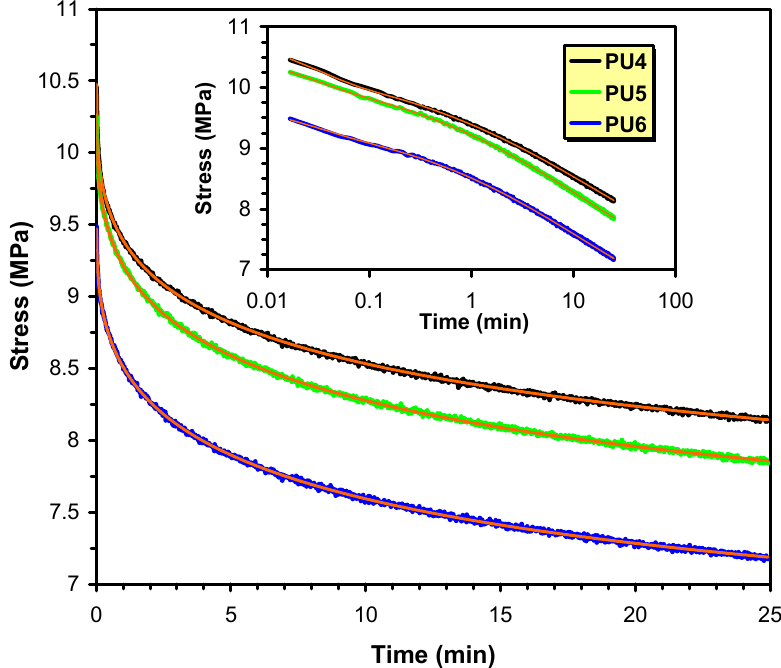
Figure 5. Stress ( σ ) versus time relaxation curves for the samples PUs 4–6 (initial elongation was 100%). The inset shows the corresponding stress ( σ ) versus time relaxation curves on a logarithmic x -axis scale. The orange solid lines represent the fitted curves by using Equation (7). The fitted parameters for PU 4 are A 1 = 0.51 MPa, A 2 = 3.61 MPa, A 3 = 7.0 MPa, τ 1 = 0.027 min, τ 2 = 17.7 min and λ = 0.33, for PU 5 are A 1 = 0.35 MPa, A 2 = 3.56 MPa, A 3 = 6.8 MPa, τ 1 = 0.027 min, τ 2 = 13.5 min and λ = 0.35, and for PU 6 are A 1 = 0.29 MPa, A 2 = 3.28 MPa, A 3 = 6.3 MPa, τ 1 = 0.027 min, τ 2 = 11.9 min and λ = 0.37.